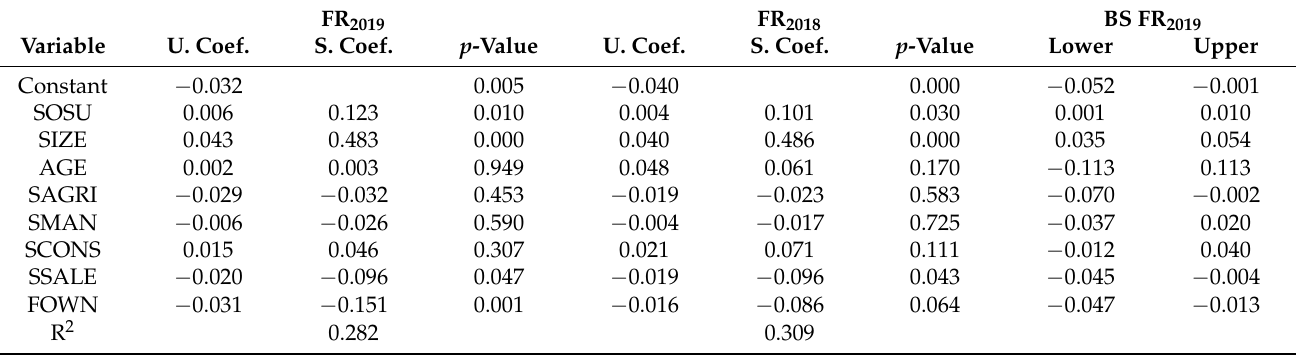
Table 6. Models with SOSU as the independent variable (N = 421).